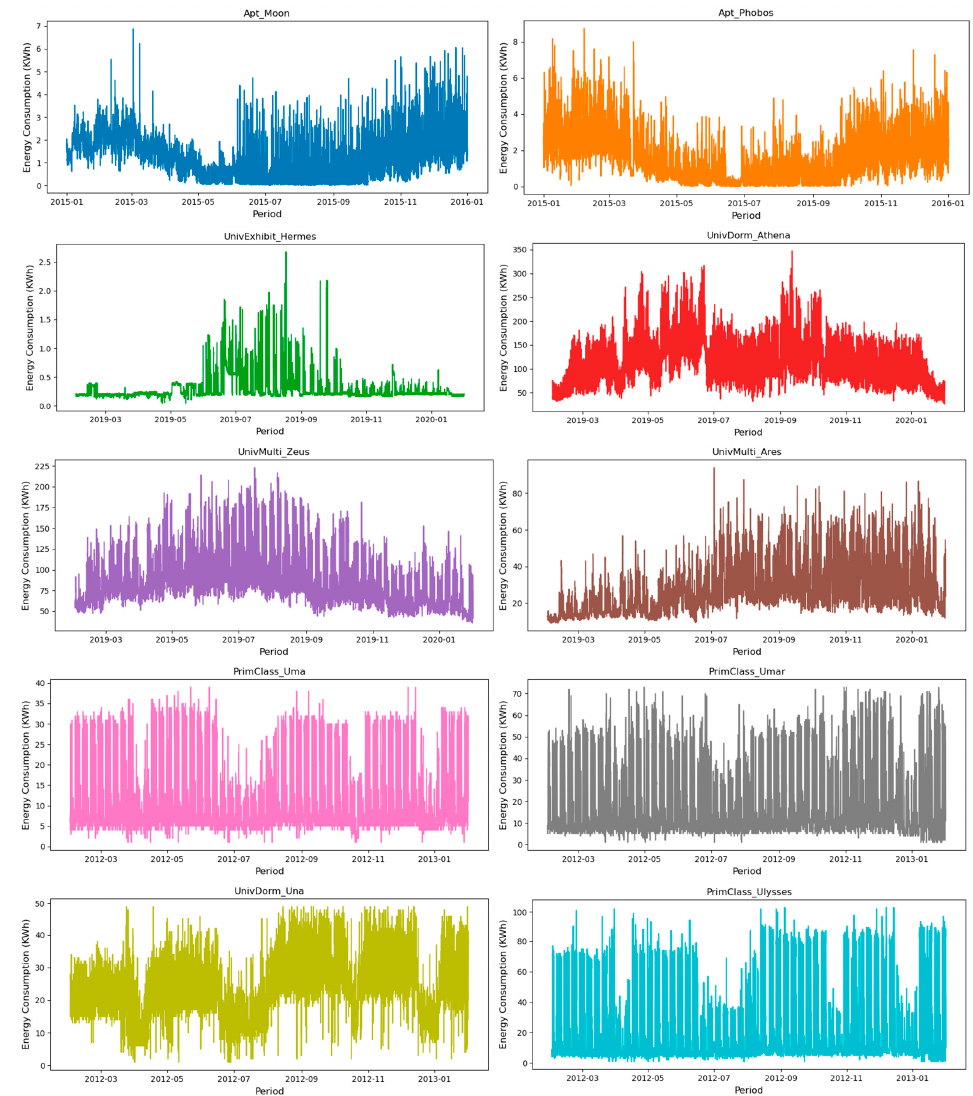
Figure 6. Energy consumption pattern in each building.